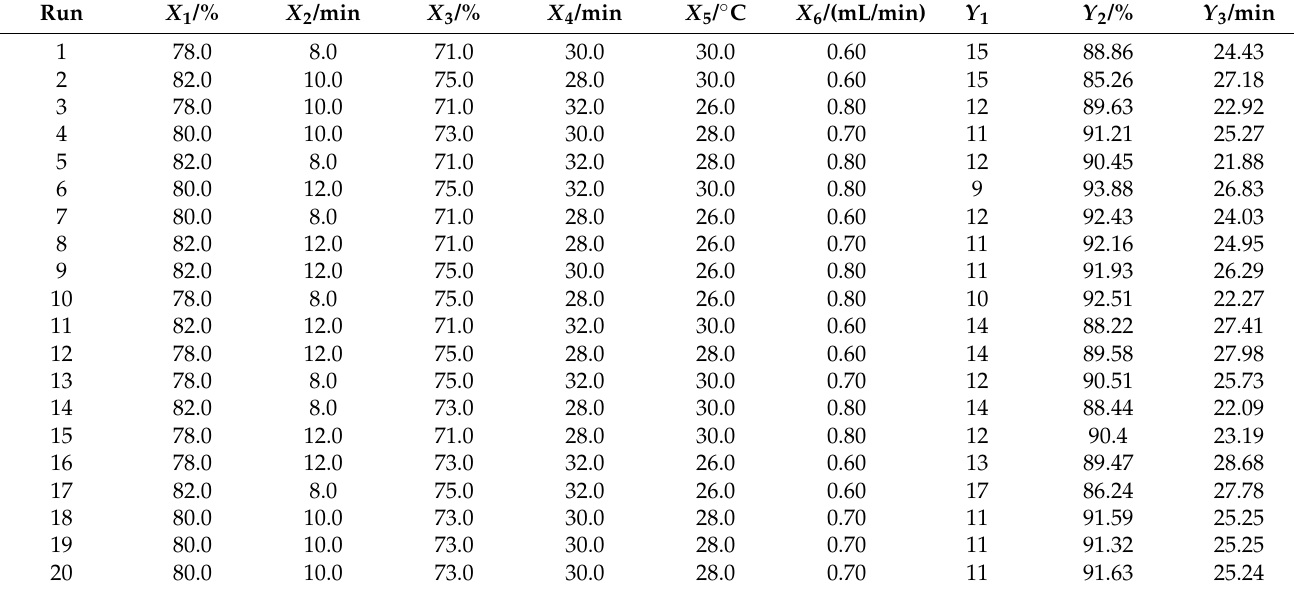
Table 3. Experimental conditions and results of